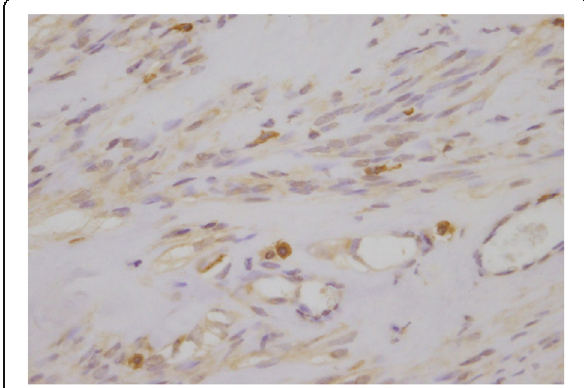
Fig. 2 Pathological examination. Immunohistochemistry showed the presence of erythropoietin in the cells of the uterine myoma. Anti- erythropoietin polyclonal antibody stains the cytoplasm of smooth muscle cells brown. Magnification is ×